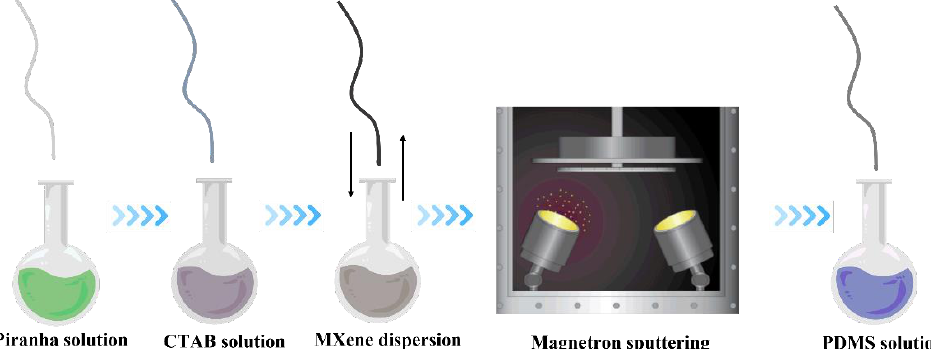
Figure 1. Schematic illustration of fabricating conductive strain-sensing yarns.